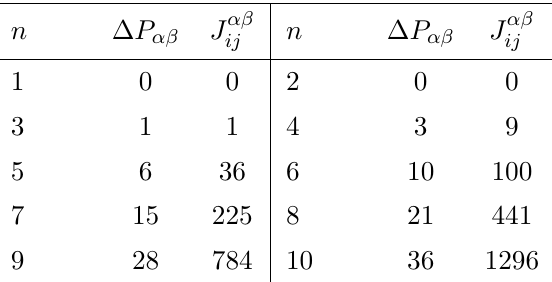
Table 1 . A summary of the total number of independent (cid:1) P (cid:11)(cid:12) and Jarlskog invariants J (cid:11)(cid:12) correspond to number of neutrino (cid:13)avors up to